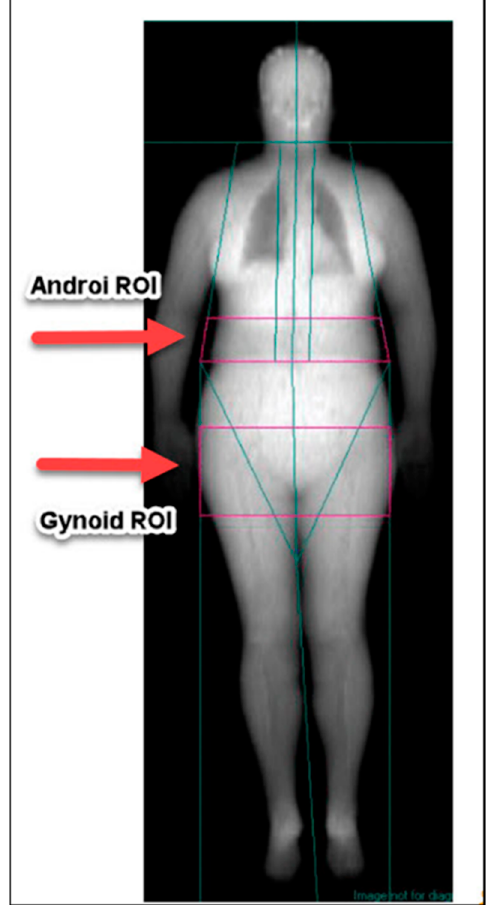
Figure 1. Example scan image with android (top arrow) and gynoid regions (bottom arrow) identified from the GE LUNAR iDXA Narrow-Angle Dual Energy X-ray Densitometer with SmartFAN™ (GE Medical, Software Lunar DPX enCORE 2012 version 14.0, Madison, WI, USA).